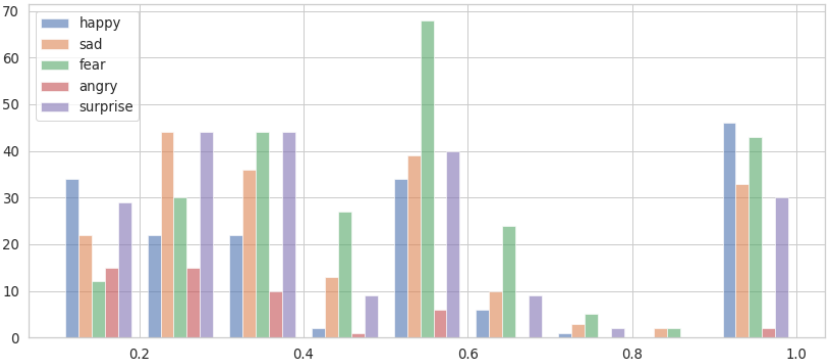
Figure 13. Histogram of Odysee comments’ emotion detection.